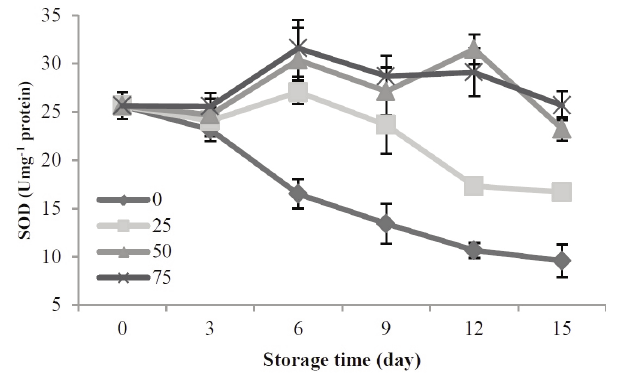
Fig. 5 ­ Superoxide dismutase (SOD) activity in figs ( Ficus carica L.) ‘Siyah’ fruit treated with Aloe vera gel (0, 25, 50 and 75%) during cold storage at 2°C. Vertical bars represent standard error of means of three experiments with four replicates determinations per experiment.